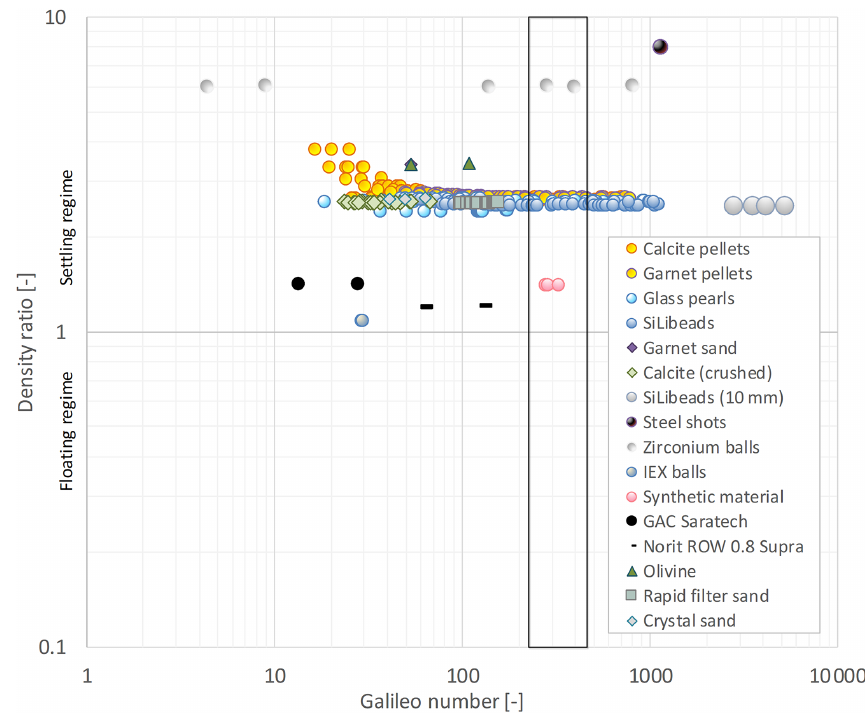
Figure 9. State diagram. Galileo number, Ga , versus specific gravity number, ρ , with examined particles.